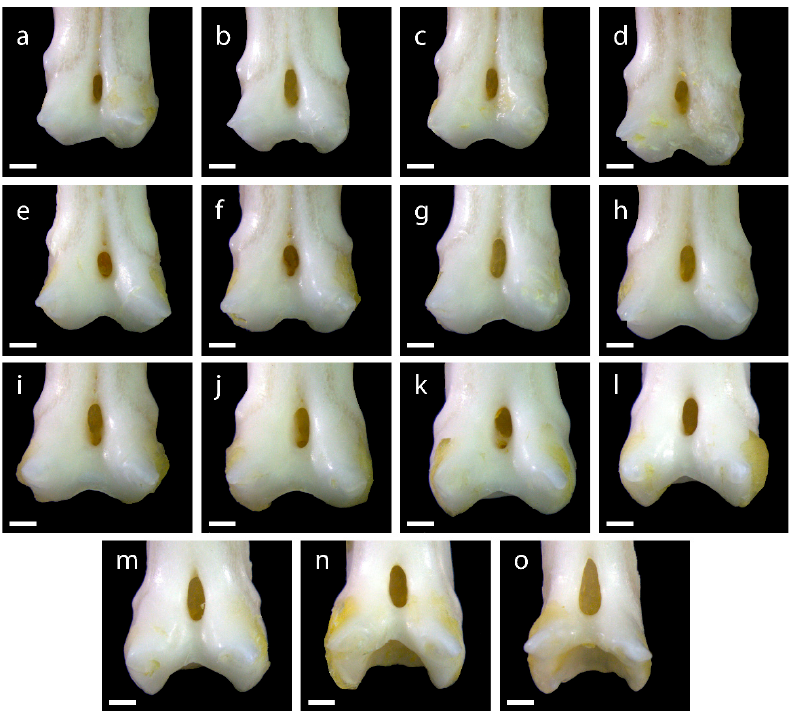
Figure A4. Microscopic images of the posterior view of the pinnules of P. bichir PO5. The images ( a – o ) correspond to the 1st, 2nd, 3rd, 4th, 5th, 6th, 7th, 8th, 9th, 10th, 11th, 12th, 13th, 14th, and 15th pinnules, respectively. Scale bars = 1 mm.